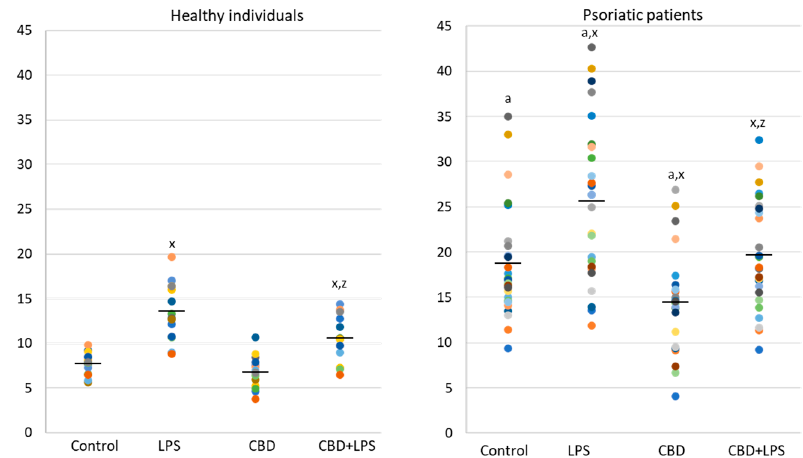
Figure 6. Level of cfDNA (ng/mL) in supernatants obtained after 1h neutrophils, from healthy subjects ( n = 14) and psoriatic patients ( n = 28), incubation with LPS, cannabidiol and LPS with cannabidiol. a—statistically significant difference between neutrophils from patients with psoriasis vulgaris and healthy subjects p < 0.05; x—statistically significant difference between treated neutrophils (with LPS, CBD, or LPS + CBD) and non-treated (control) cells; p < 0.05; z—statistically significant difference between neutrophils treated with LPS + CBD and treated only with LPS; p < 0.05.